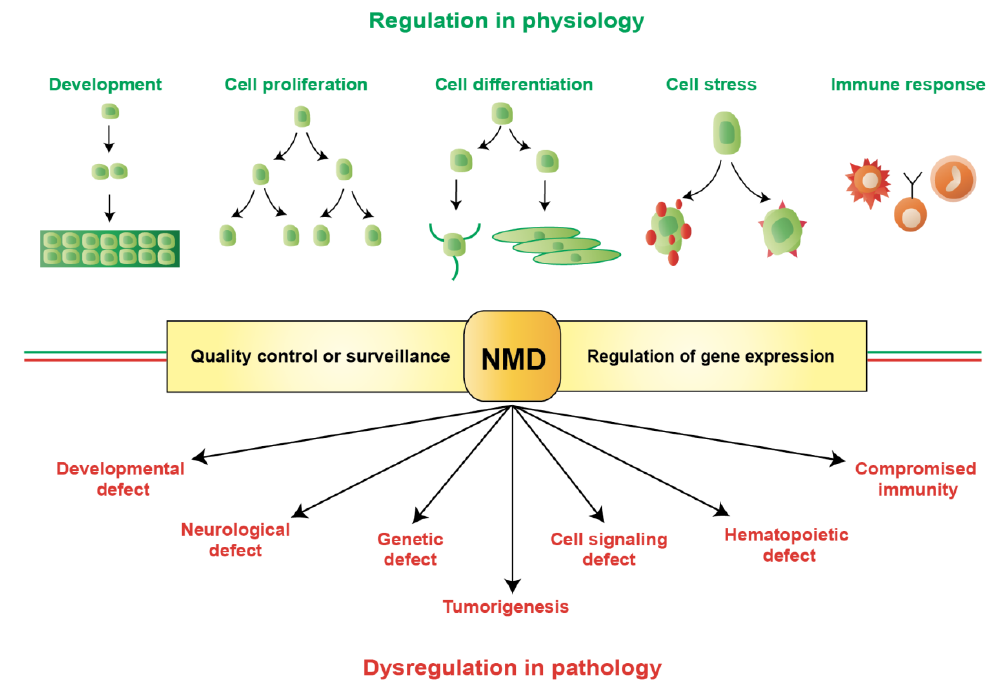
Figure 1. Regulation and dysregulation of nonsense-mediated mRNA decay (NMD) in physiology and pathology. NMD is an evolutionarily conserved pathway comprising a dual function to modulate gene expression: a surveillance or quality control mechanism to recognize and degrade erroneous mRNAs selectively; and a regulatory mechanism to control transcript abundance. By regulating gene expression, NMD promotes diverse physiological functions (shown at the top), including development, cell proliferation, differentiation, cellular stress, immune responses, etc. Mutations or alterations that impair the function or expression of proteins associated with the NMD pathway can be deleterious to cells and may cause pathological consequences (shown in the bottom), as implicated in developmental and neurological disability, genetic defect, cell signaling defect, hematopoietic defect, compromised immunity, and cancer. Therefore, NMD is strictly regulated in cells to safeguard the fidelity of gene